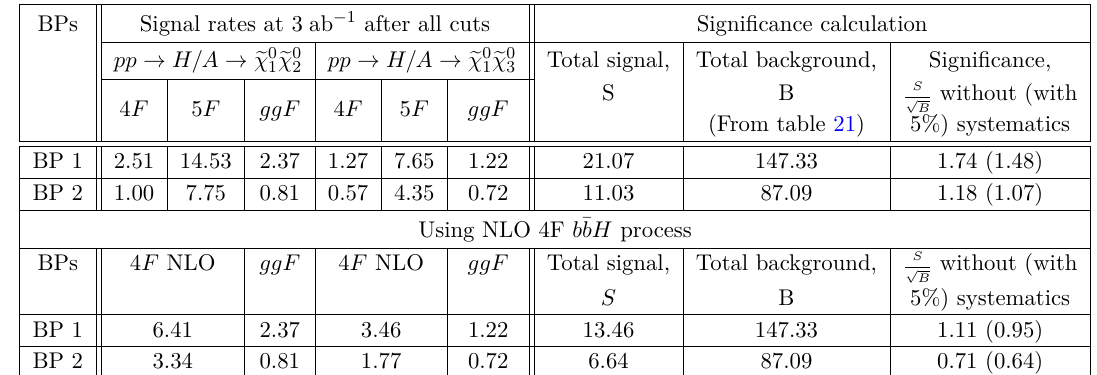
Table 22. The signal yield along with signal significance for the γγ + /E